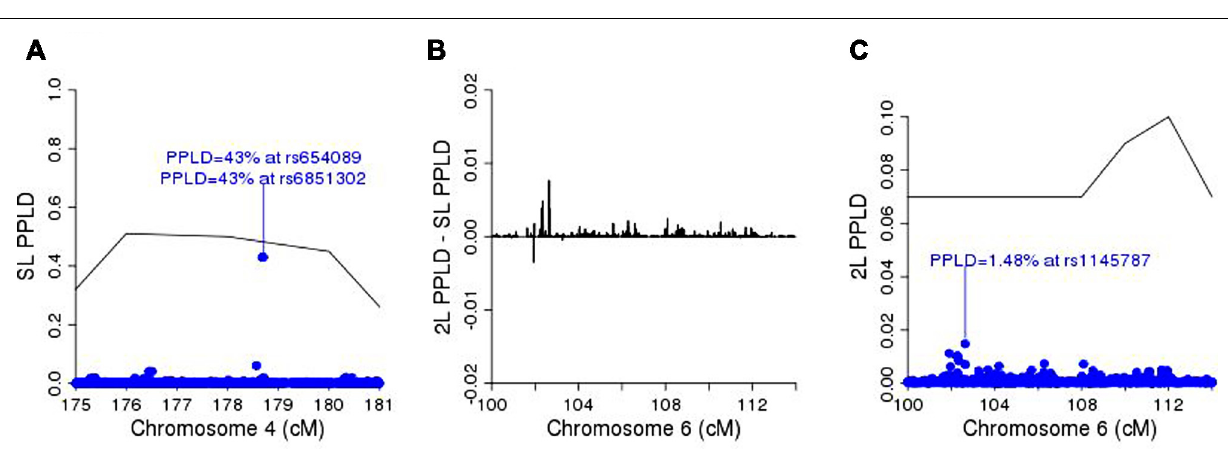
FIGURE 5 | (A) SL-PPLD under linkage peak region on chromosome 4 with solid line depicting PPL; (B) 2L-PPLD – SL-PPLD across linked region on chromosome 6; (C) 2L-PPLD under the 2L linkage peak on chromosome